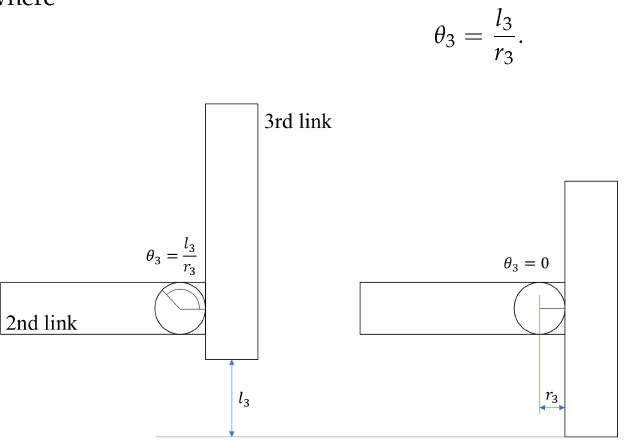
Figure 4. The third link of the